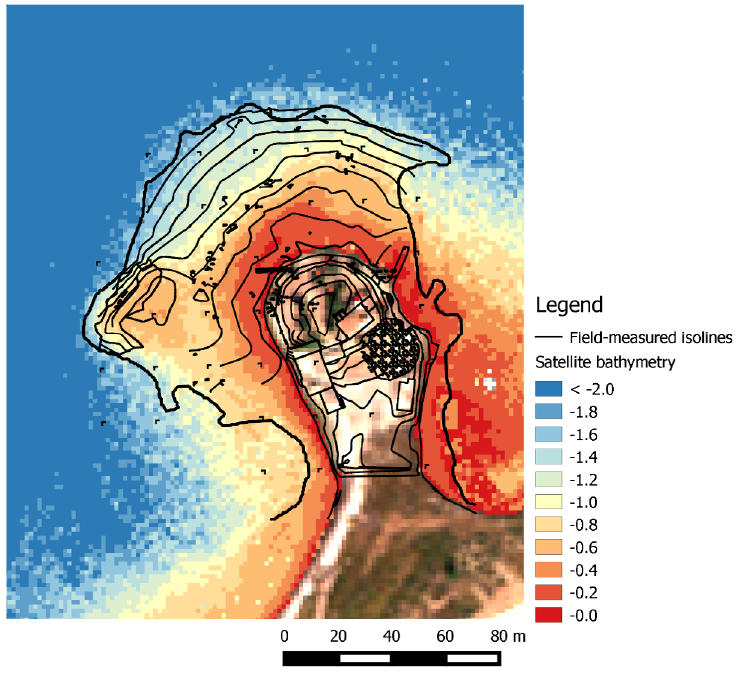
Figure 7: Comparison between depth isoline map (0.2 m separation) created during the 2014 Metohi field campaign and bathymetry map (also 0.2 m separation) produced with WorldView-2 data acquired on